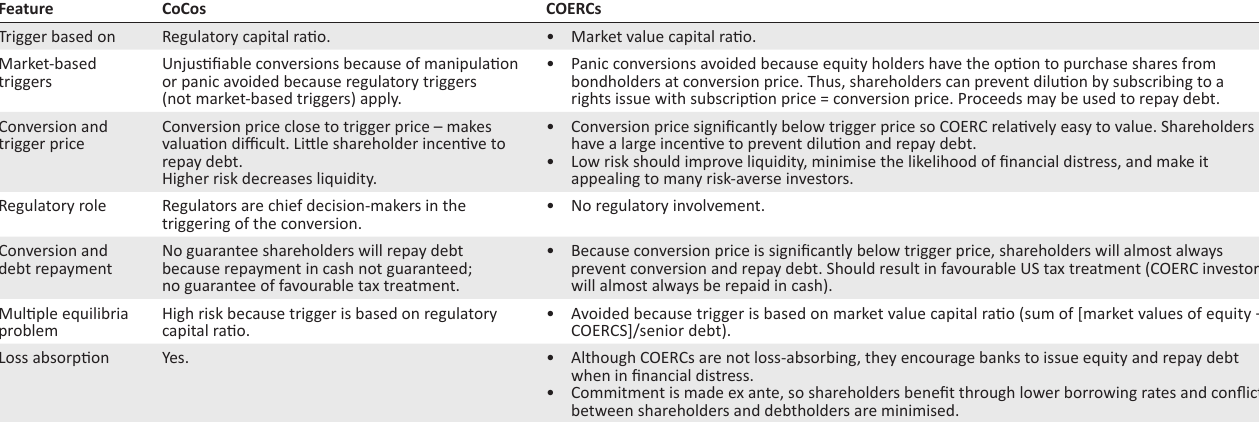
FIGURE 3: Principal benefits of Call Option Enhanced Reverse TABLE 2: Summary and comparison of contingent convertible debt and Call Option Enhanced Reverse Convertible design features.